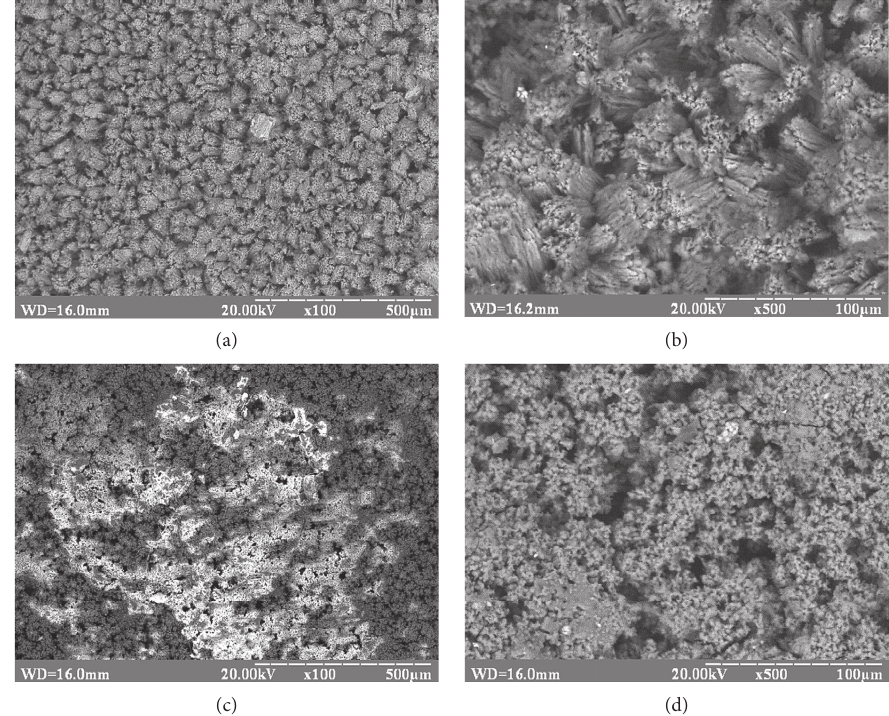
Figure 6: SEM images of the scaled surface at different magnification: (a) and (b), tap water; (c) and (d), tap water with 10mL/L of the radish cake extract.